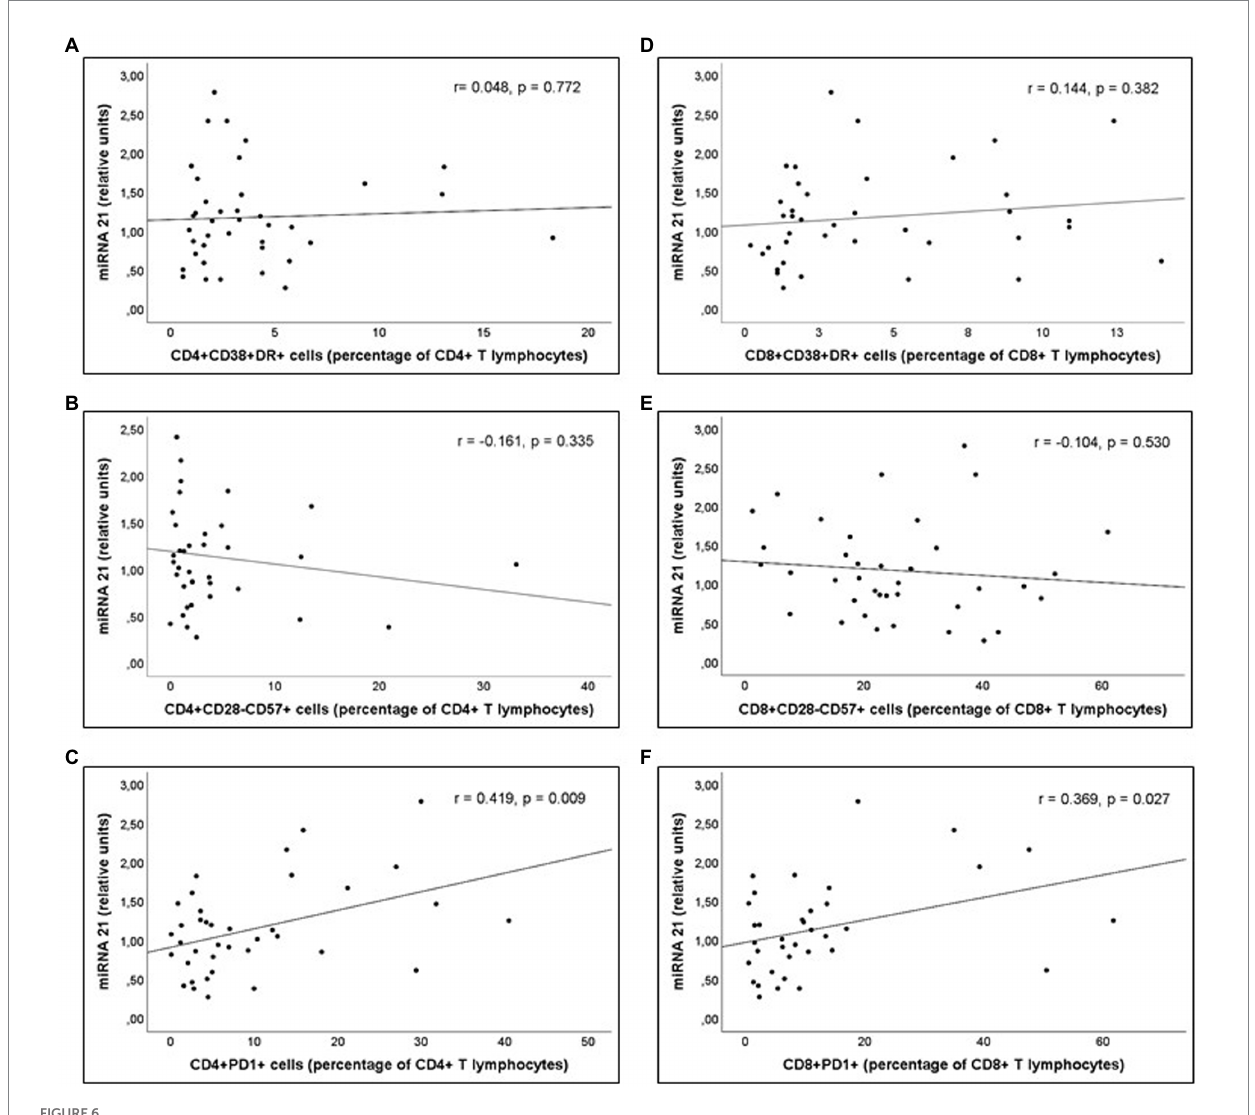
FIGURE 6 Correlations of miR-21 levels and (A) Percentage of CD4+DR+CD38+ (CD4+ T activated lymphocytes), (B) Percentage of CD4+CD28-CD57+ (“exhausted” CD4+ T lymphocytes), (C) Percentage of CD4+PD1+ (“predisposed to death” CD4+ T lymphocytes), (D) Percentage of CD8+DR+CD38+ (CD8+ T activated lymphocytes), (E) Percentage of CD8+CD28-CD57+ (“exhausted” CD8+ T lymphocytes), and (F) Percentage of CD8+PD1+ (“predisposed to death” CD8+ T lymphocytes), in Group 2 patients (PLWH with prolonged undetectable viral